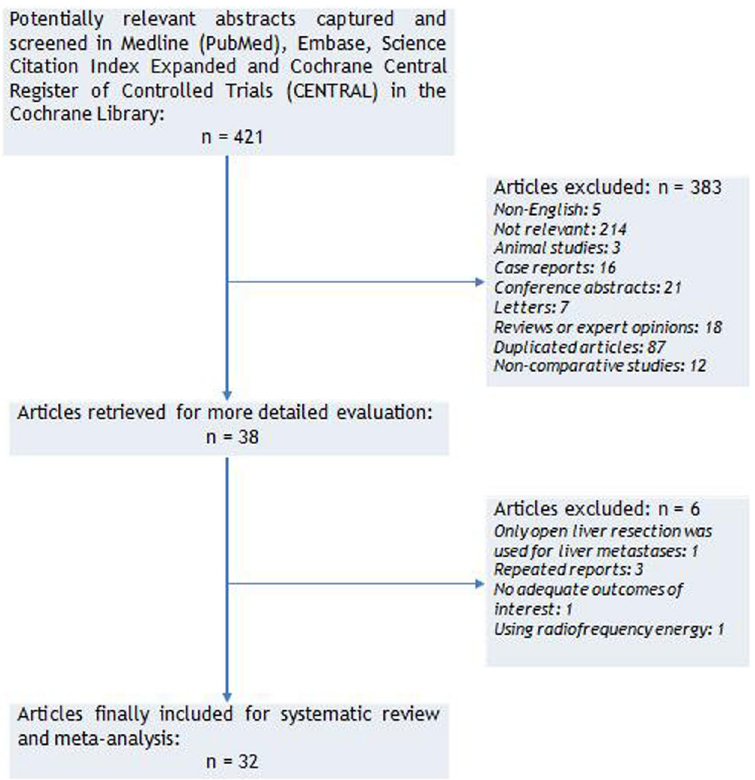
Figure 1. Study selection flow chart according to PRISMA